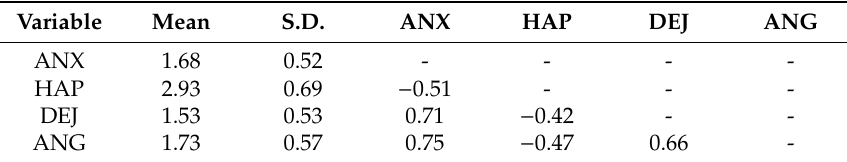
Table 2. Means, standard deviations, and correlations.